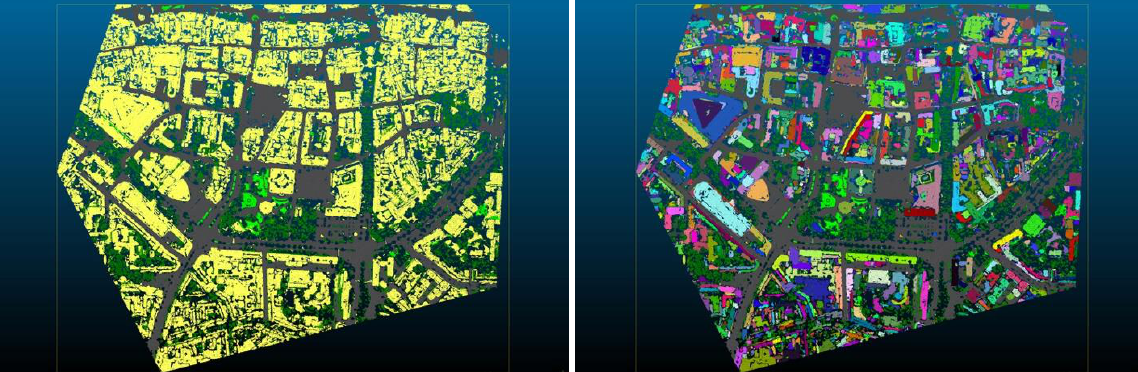
Figure 8. Classification and segmentation result for the point cloud of Dortmund City Center: classification (left) of buildings (yellow), vegetation (green) and GLOs (grey); final results (right) with separated buildings.